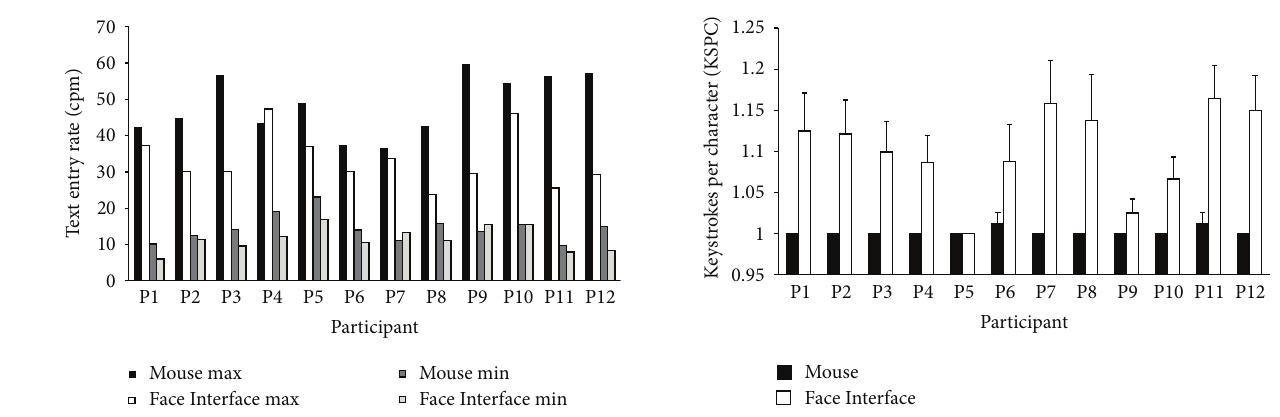
Figure 10: Maximum and minimum values for mouse and Face Interface.